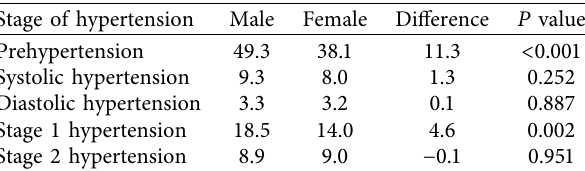
Table 3: Prevalence of the different stages of hypertension among male and female subjects in the study